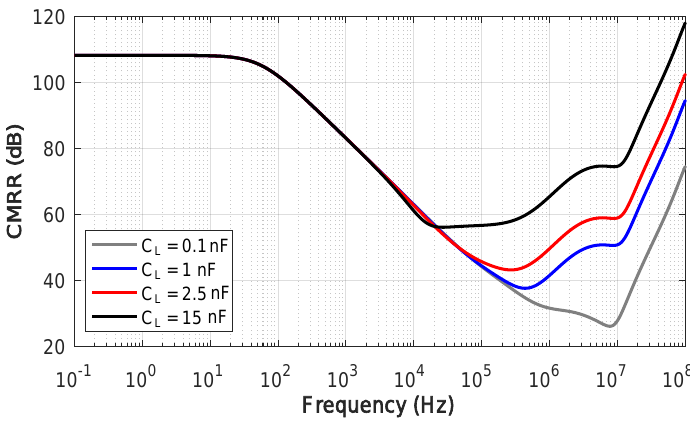
Figure 14. Simulated common-mode rejection ratio of the proposed amplifier with 0.1–15-nF load